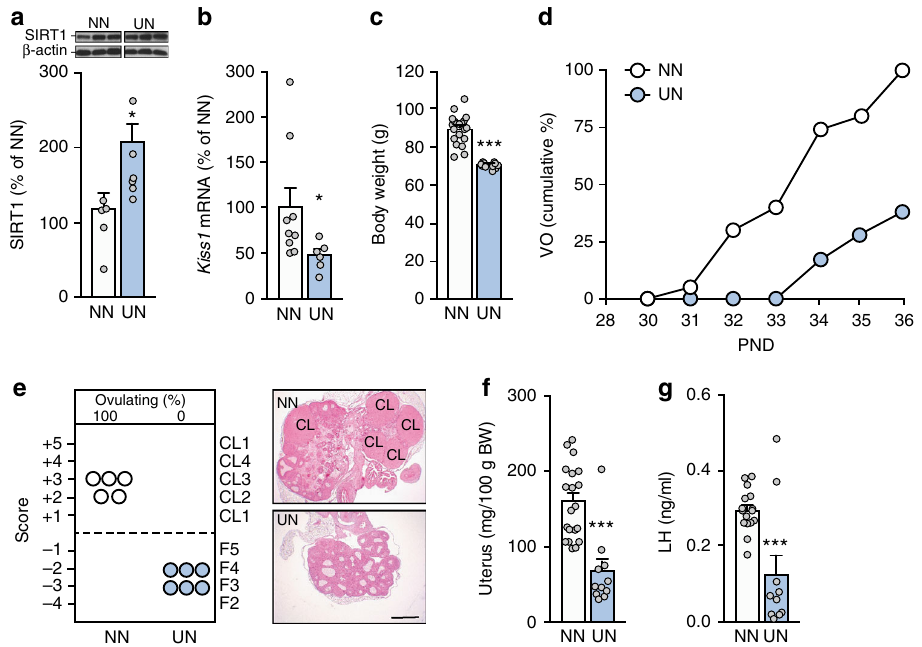
Fig. 2 Changes in hypothalamic SIRT1 and pubertal timing induced by undernutrition. a , b SIRT1 content and Kiss1 mRNA levels at PND36 in the MBH of animals fed a normal diet (NN; white bars) or given restricted access to food (undernutrition, UN; light blue bars) during prepubertal development. c Body weight of NN and UN animals. d Cumulative percent of NN and UN animals showing vaginal opening (VO). e Histological score of follicular development/ ovulation and representative images of ovarian maturation in the NN and UN groups; CL: corpus luteum. f Uterine weight and g Plasma LH levels. The bar histograms represent the mean ± SEM. * p < 0.05; *** p < 0.001 vs. NN group (two-sided Student ’ s t test). For protein analyses in panel a , three representative bands per group, run in the same original western blots, are presented. The scale bar in panel e corresponds to 600 μ m. Total group sizes were: NN = 20 and ON = 10; while phenotypic and hormonal parameters were assayed in the whole groups (in the case of LH levels, for all serum samples that were available), hypothalamic protein ( a ) and RNA ( b ), as well as ovarian histological ( e ) analyses were conducted in a representative subset of randomly assigned samples from each group, with the following distribution: a n = 5; b n = 6 − 8; e n = 5 − 6